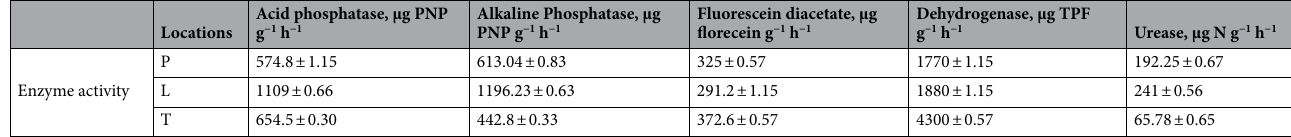
Table 2. Enzyme activities of rhizospheric soil of Shisham at Pantnagar (P), Lachhiwala (L) and Tanakpur (T). Each value is the mean of three replicates. Data was analysed statistically at the 5% (p < 0.05) level of significance.